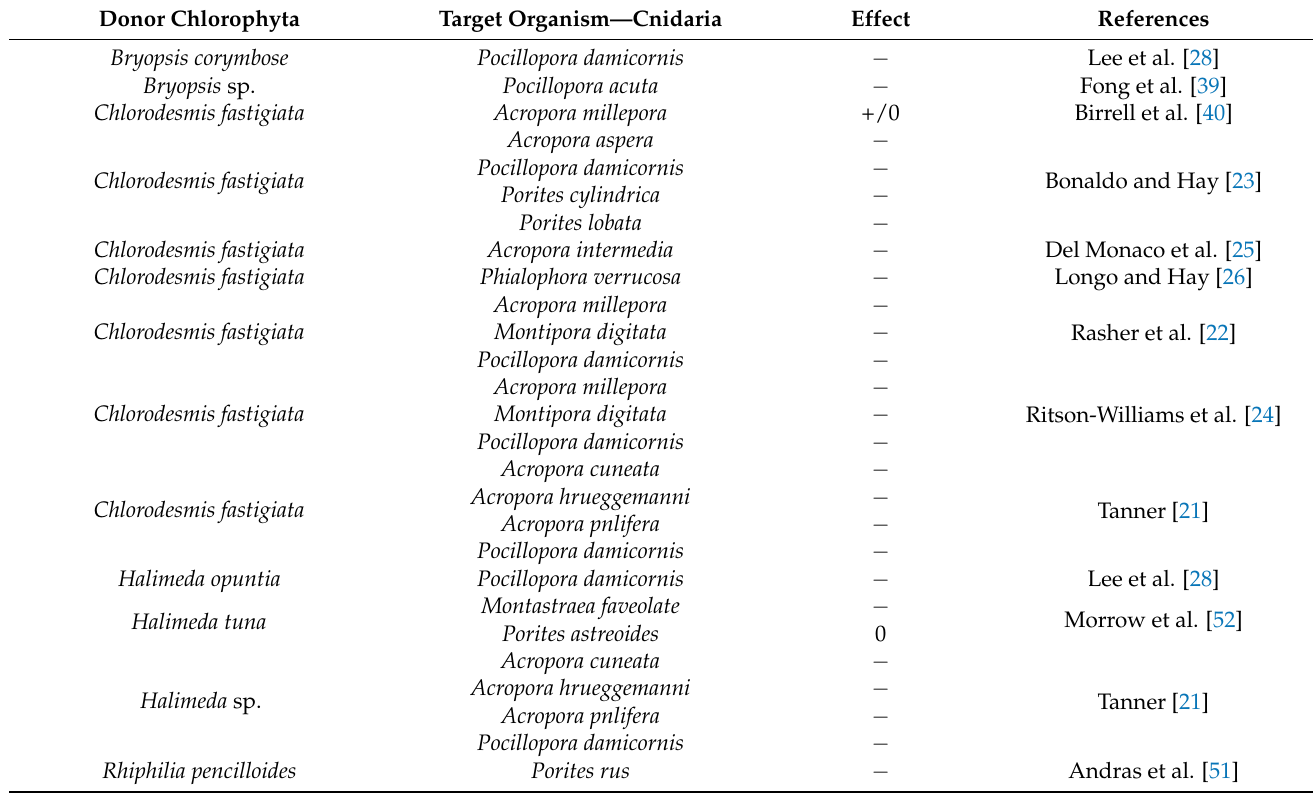
Table 1. Examples of allelopathic activity of green algae against competitors and herbivores. Donor Chlorophyta Target Organism—Cnidaria